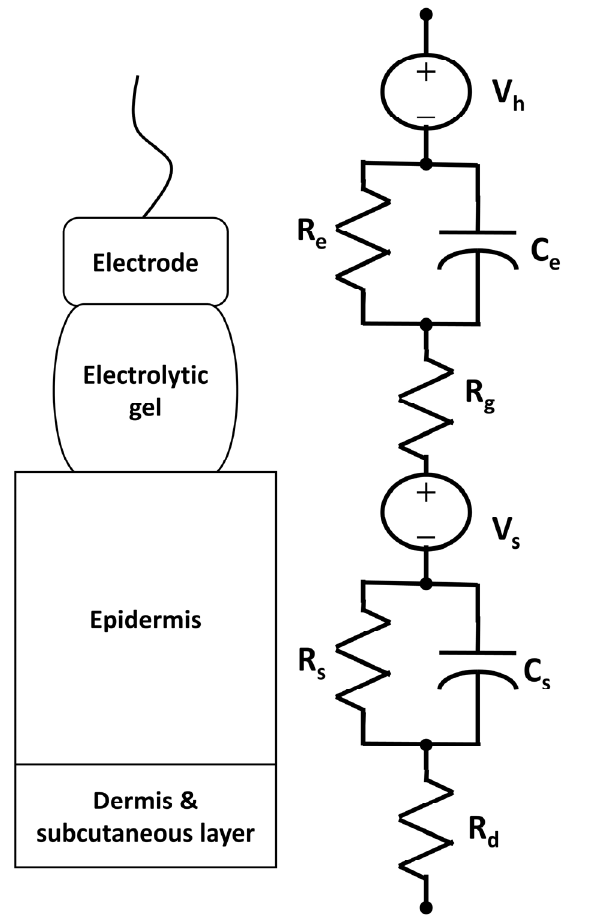
Figure 2. Electrical model of biopotential measurement at the skin